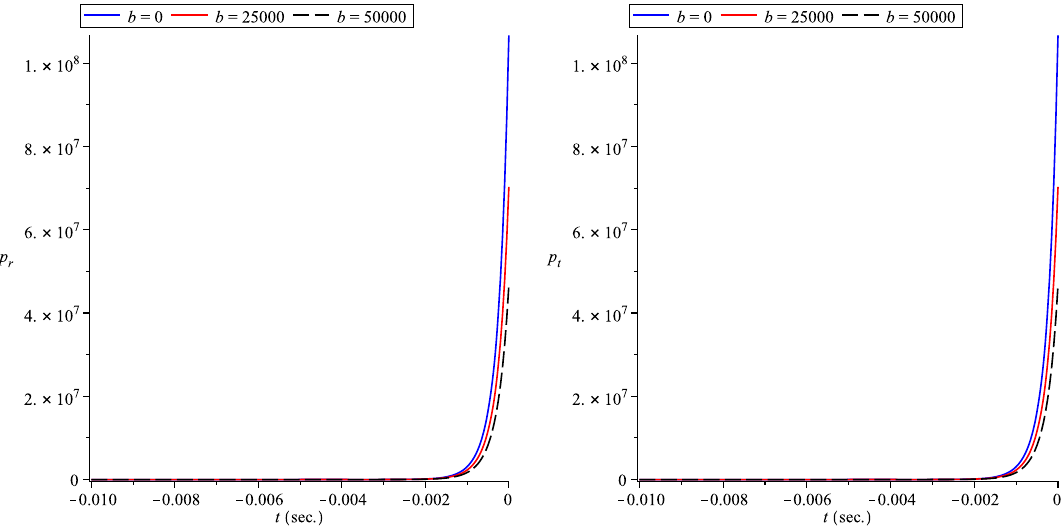
Fig. 4 (Left) evolution of radial pressure p r vs. t for different charge/mass ratios. Delay is observed in the radial pressure with increasing charge. (Right) evolution of tangential pressures p t vs. time t (s). The evolution in tangential pressure also delays with increasing